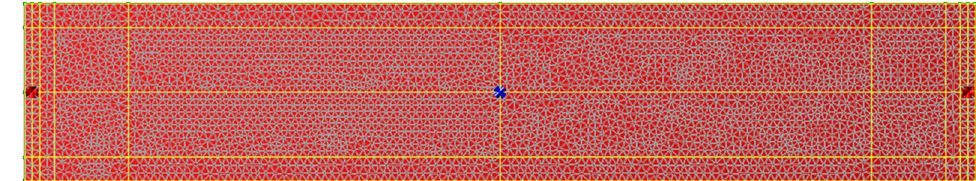
Figure 10. Mesh used in the RTM process simulation.